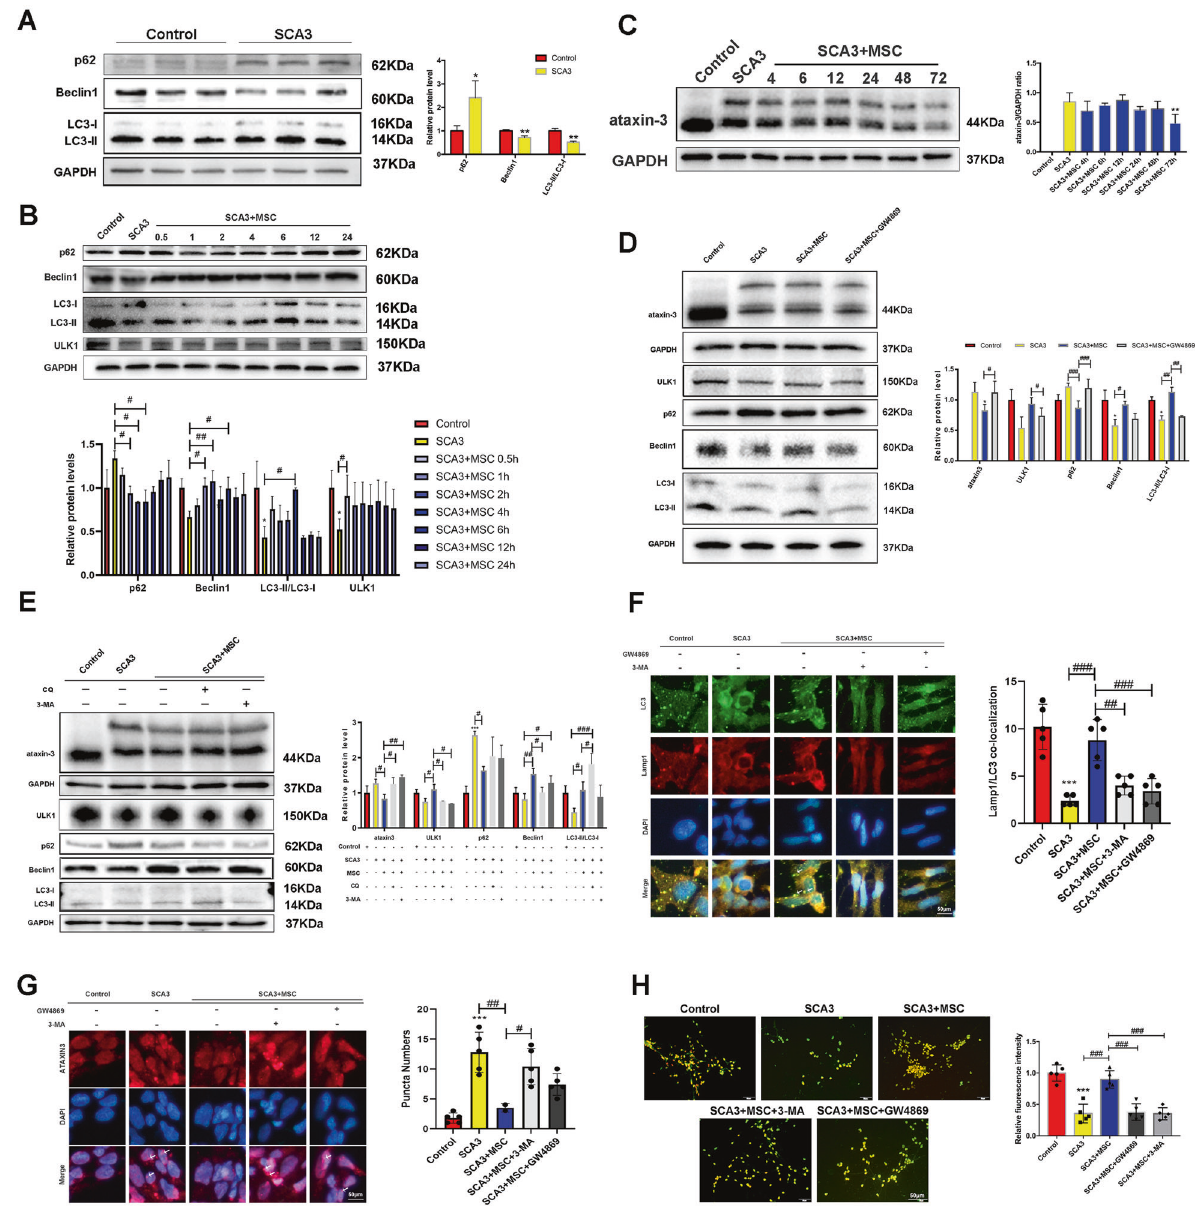
culture for 1 h. C Time-dependent expression of mutant ataxin-3 after MSCs therapy for 72 h. D The effects of GW4869 on the expression of p62, Beclin1, LC3, ULK1, and ataxin-3. E The effects of 3-MA and CQ on the expression of p62, Beclin1, LC3, ULK1, and ataxin-3 after MSCs therapy. F LC3 and Lamp1 co-localization after MSCs by immuno fl uorescence (scale bar: 50 μ m). G DAPI and mutant ataxin-3 co-localization after MSCs by immuno fl uorescence (scale bar: 50 μ m). H Acidic vesicles induced by MSCs treatment using acridine orange staining (scale